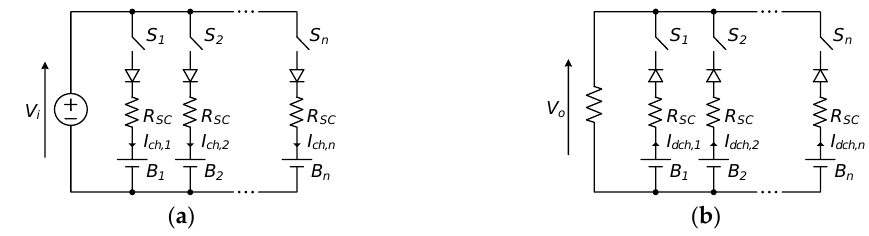
Figure 2. Behavioral model of the SC converter; ( a ) SIMO configuration; and ( b ) Multi-Input Single-Output (MISO) configuration.